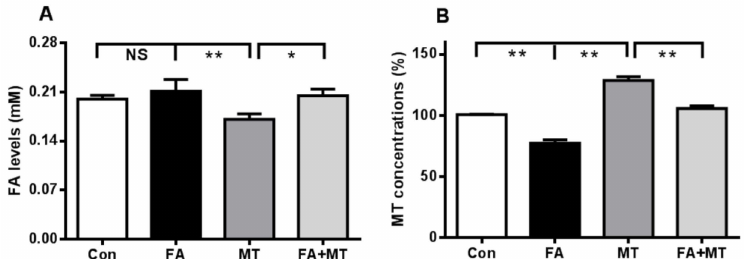
Figure 5. Changes in brain FA and MT after intracerebroventricular injection of liquid FA or FA combined with MT treatment for 3 h. ( A ) A decline in brain FA levels after 0.1 mM MT injection ( n = 8 for each group); ( B ) A decline in brain MT levels after 0.1 mM FA injection, and restoration of brain MT levels after FA combined with MT treatment ( n = 8 for each group). * p < 0.05; ** p <